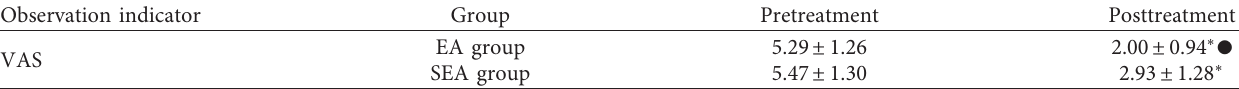
Table 2: Scores of VAS before and after treatment.